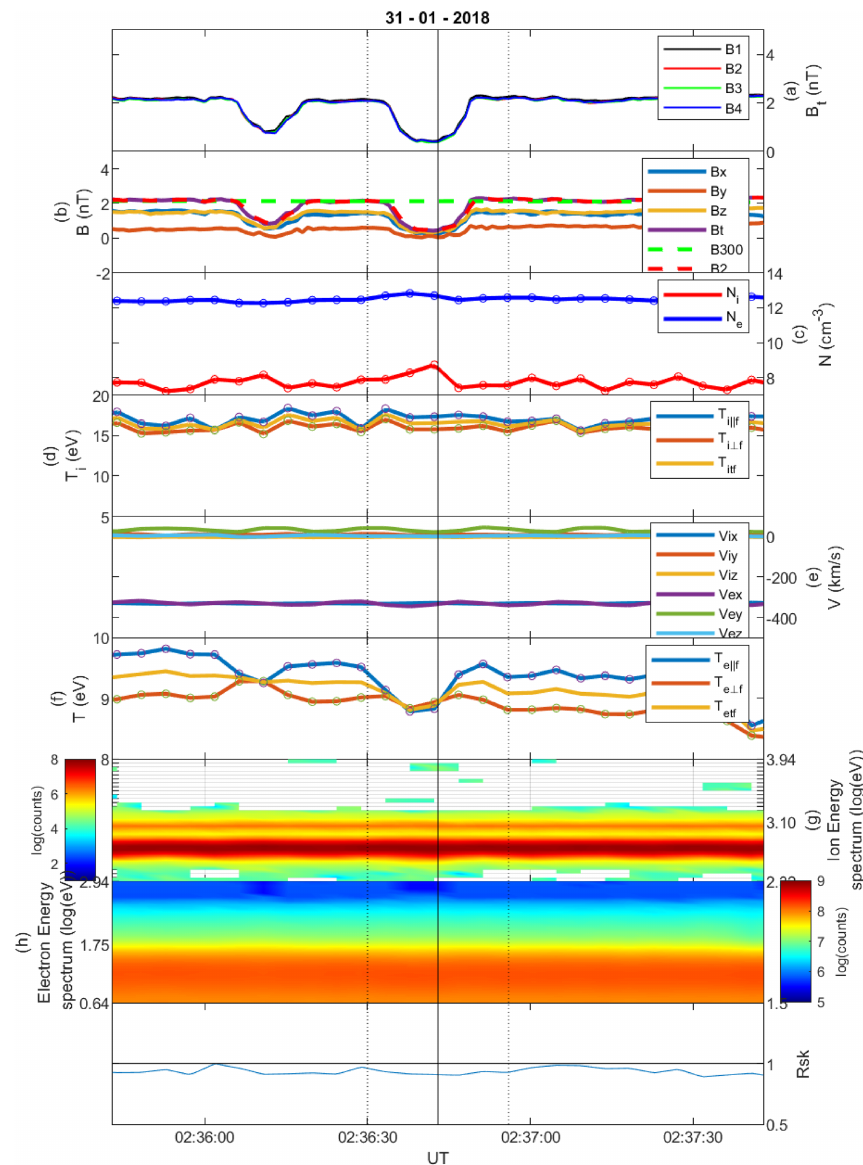
Figure 6. Linear magnetic hole on 31 January 2018, category cold. Same format as in Fig.